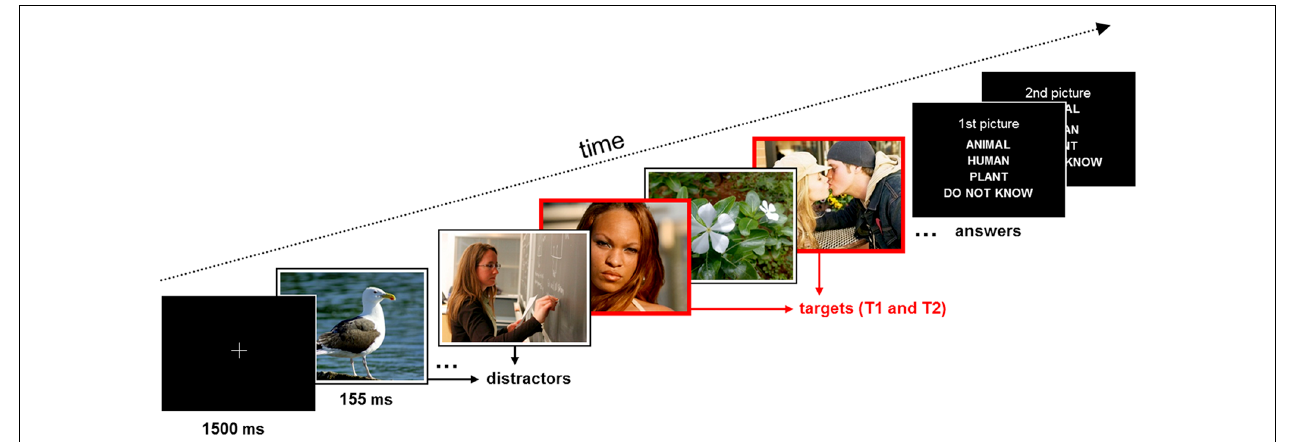
FIGURE 1 | Schematic of the trial structure and time course of stimulus events in the experiment. Participants were requested to identify the content of the two red-framed target pictures (T1 andT2; time interval between targets 310 ms) within a rapid series of white-framed distractor